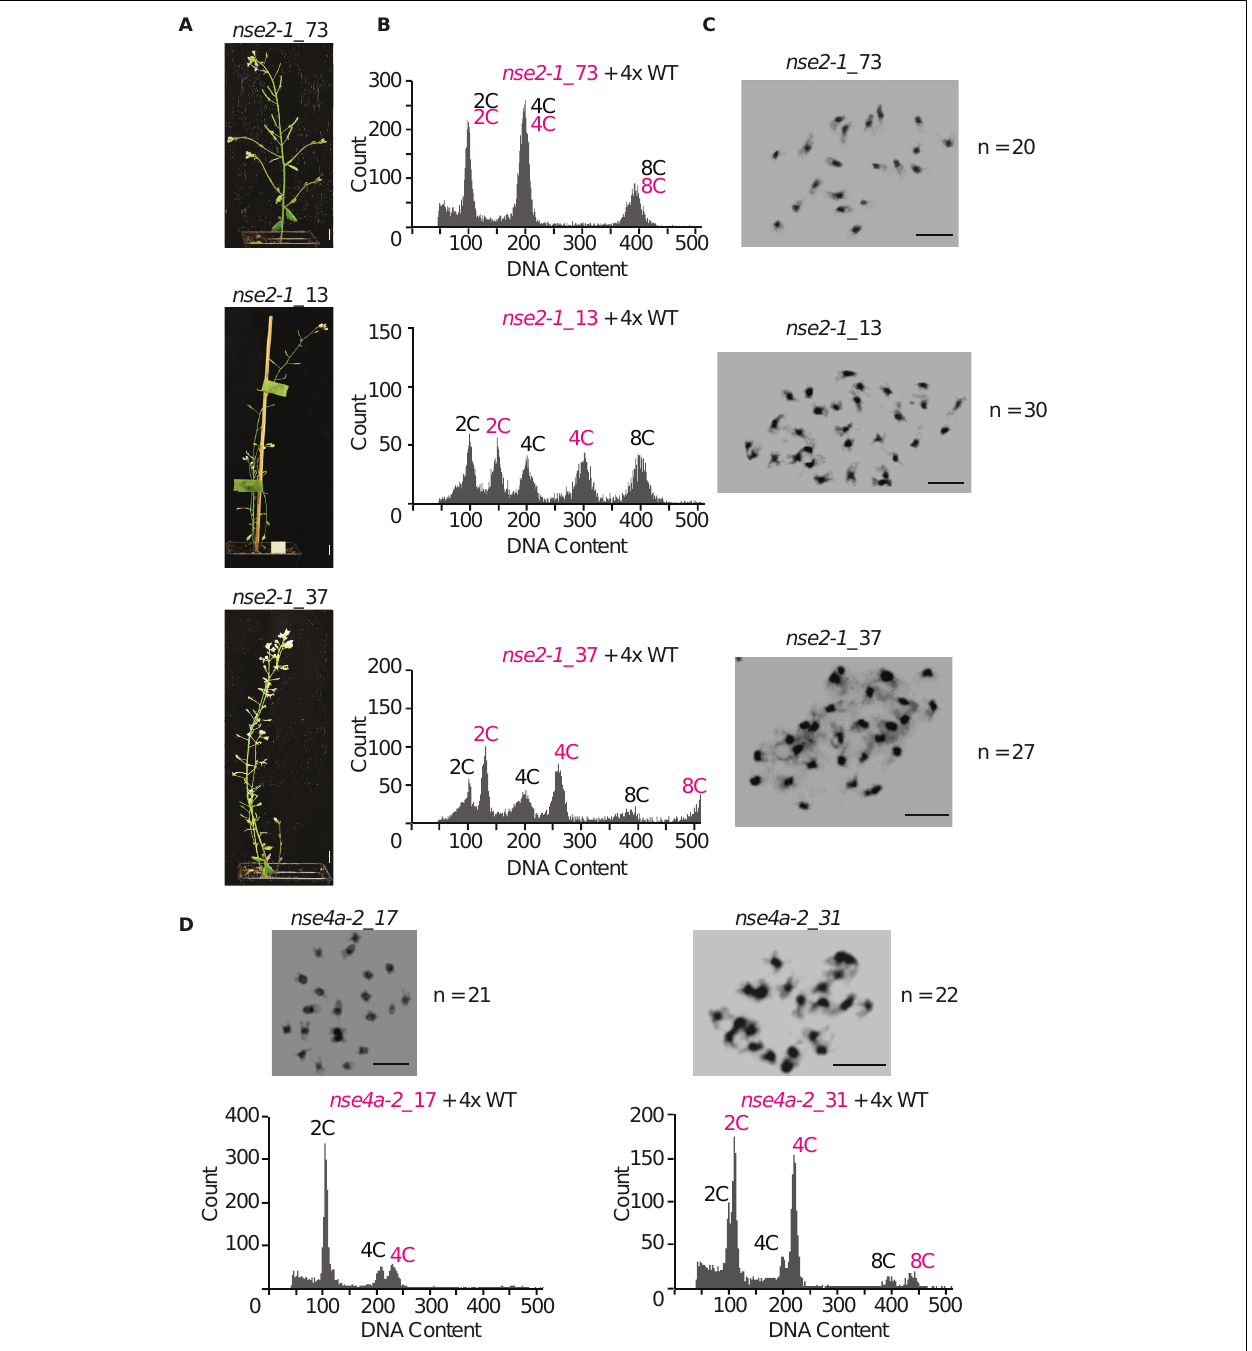
FIGURE 6 | Flow-cytometry ploidy determination in offspring of 4x nse2-1 and 4x nse4a-2 plants. (A) Phenotype of selected 4-weeks-old plants of nse2-1 _73, nse2-1 _13, and nse2-1 _37. Scale bars = 1 cm. (B) Flow-cytometry histograms of plants shown in panel (A) , indicating that nse2-1 _73 is tetraploid, nse2-1 _13 hexaploid, and nse2-1 _37 aneuploid. For the ploidy measurements, the nuclei suspension was prepared by mixing leaves from tested nse2-1 plants and 4x WT control. Multiple peaks correspond to nuclei of different C content as indicated. (C) Mitotic figures of nse2-1 _73, nse2-1_13 , and nse2-1 _37 plants. The number of chromosomes is given next to the figures. Scale bars = 5 µ m. (D) Mitotic metaphase plates and flow-cytometry histograms of the ploidy level of two selected aneuploid nse4-2 plants. Chromosome numbers are given right of the figures. Scale bars = 5 µ m. The ploidy levels were measured by preparing the nuclei suspension from a mix of the leaves the nse4a-2 candidate plant and 4x WT control. Note that an addition of a single or two chromosomes is clearer visible at 4C peaks (or 8C peaks if visible).